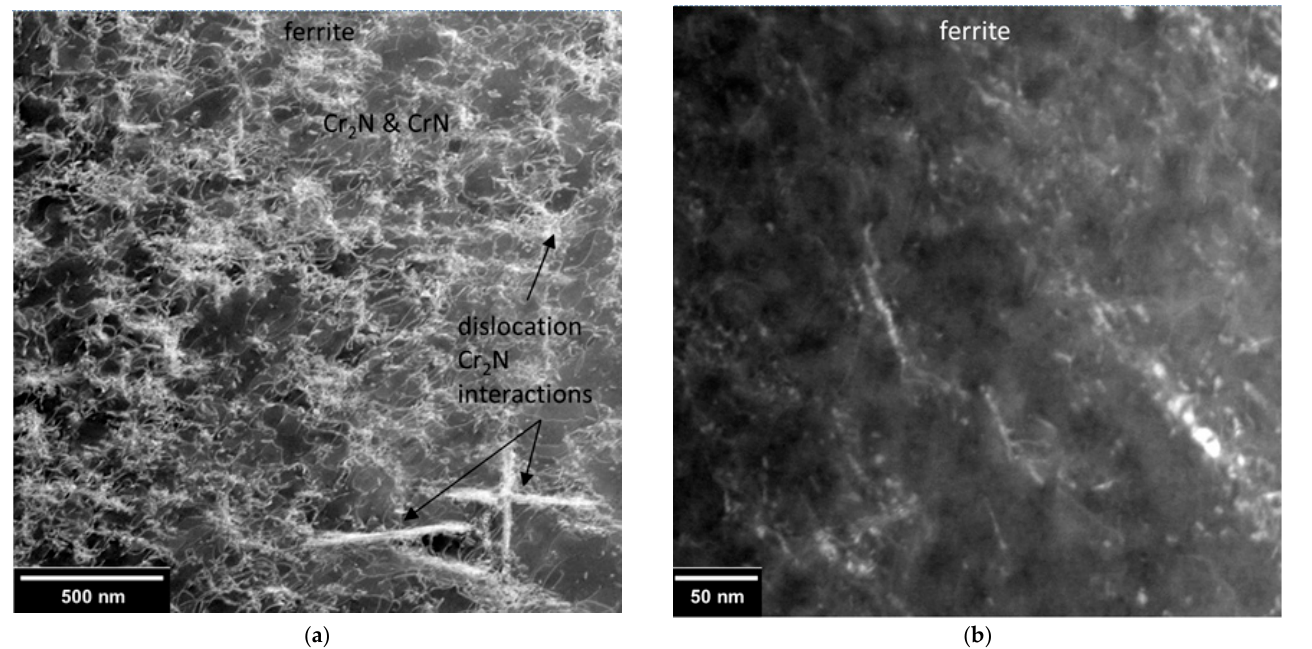
Figure A3. ( a , b ) detailed STEM images of the dislocation arrangement and precipitates in the ferrite after isothermal fatigue at 300 °C.